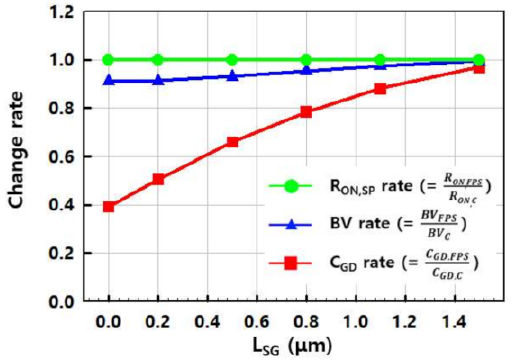
Figure 3. Change rate of C GD , R ON,SP and BV (gate-to-drain capacitance, specific on resistance and breakdown voltage) compared to C-DMOSFET (conventional planar DMOSFET) when T S,OX (thickness of the side oxide) is 250